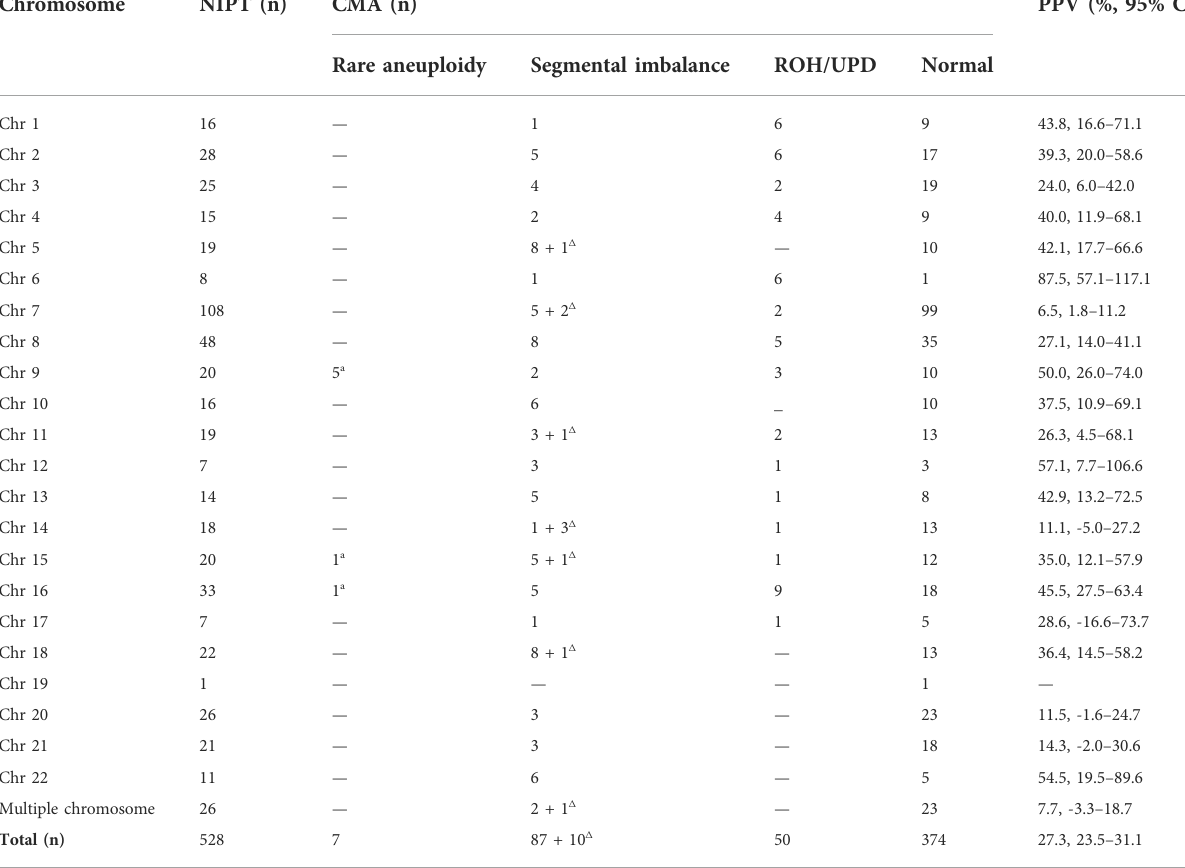
TABLE 1 Summary of the CMA results of 528 fetuses with positive NIPT results.